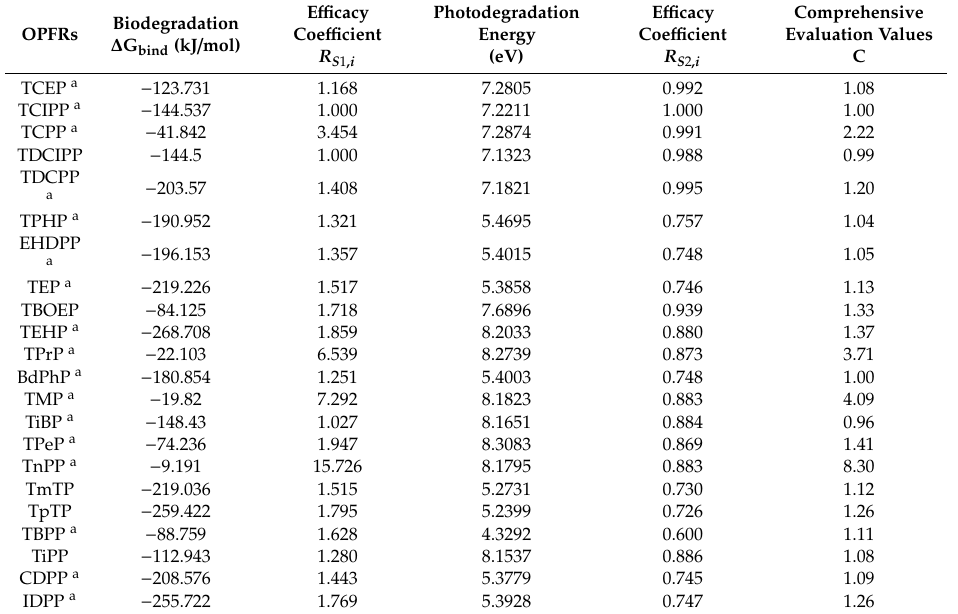
Table 1. Comprehensive e ff ect evaluation values of biodegradation and photodegradation of organophosphorus flame retardants